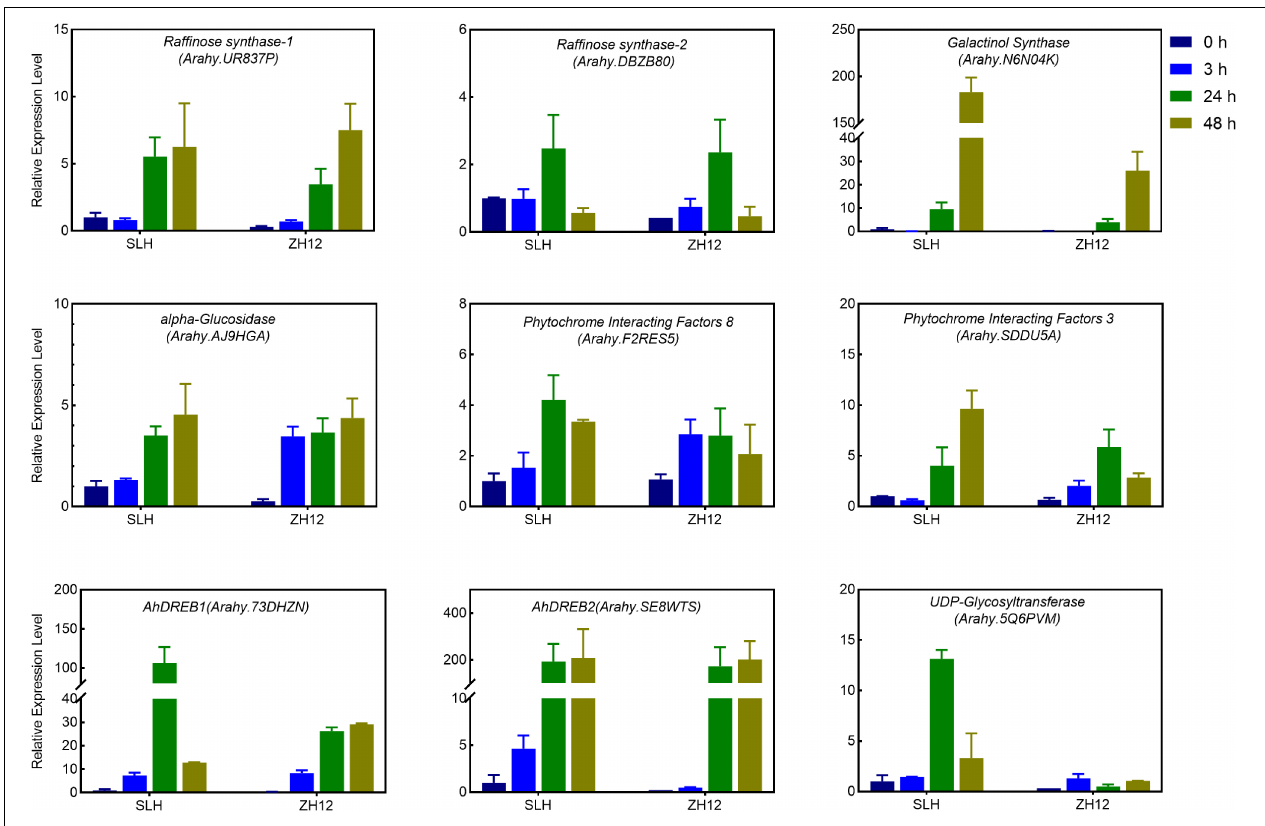
FIGURE 4 | Quantitative RT-PCR (qRT-PCR) analysis of the expression levels of selected Core Cold Tolerance Genes in the peanut seedlings subjected to cold stress. The relative transcript levels among different samples were quantified by the 2 − (cid:49)(cid:49) Ct method, with A. hypogaea Actin gene as the reference gene for normalization. Error bars indicate the S.D. of the means of three biological